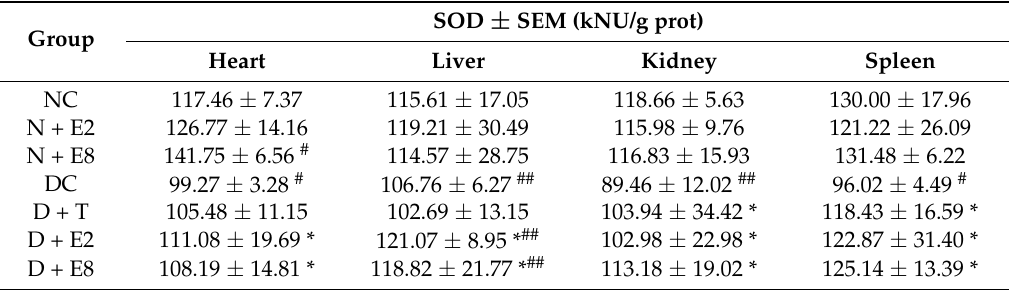
Table 4. Effects of ECE on SOD activities in organs of normal and diabetic rats. SOD ± SEM (kNU/g prot) Group Heart Liver